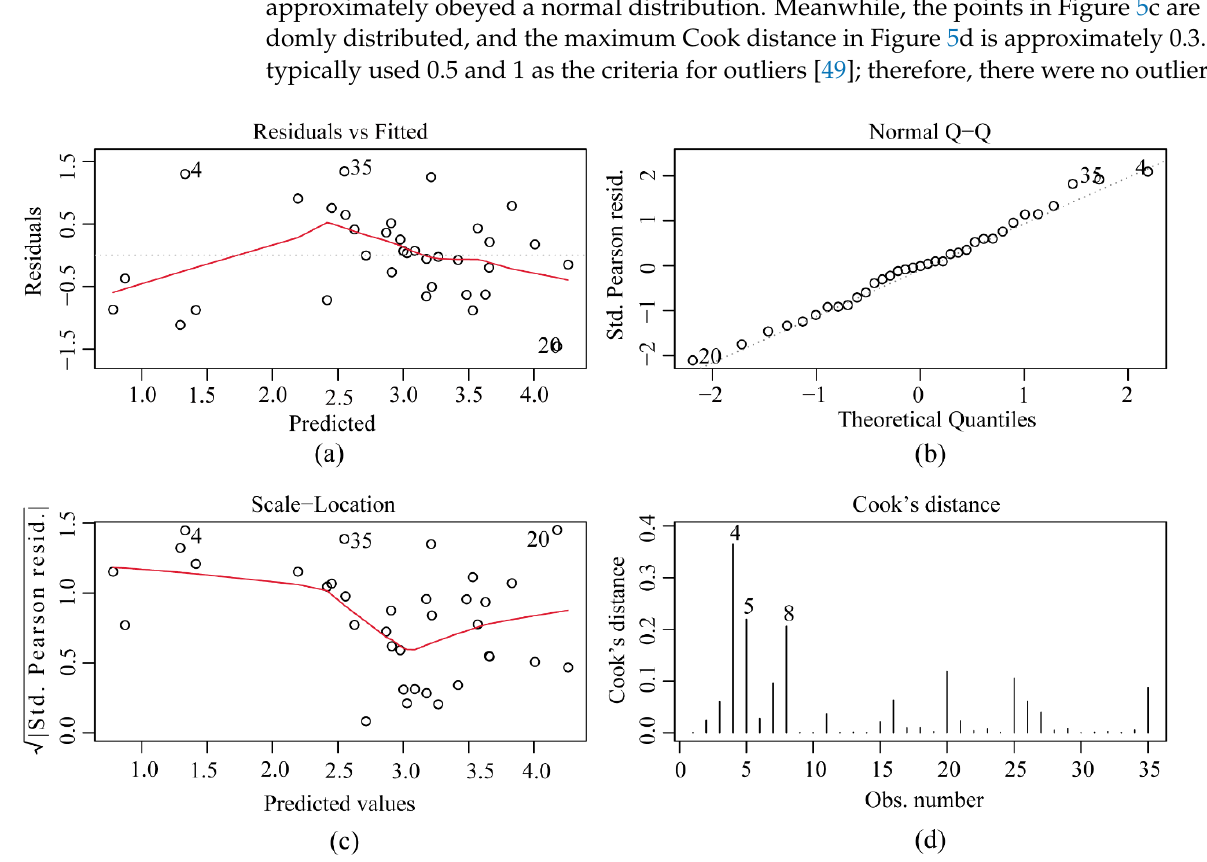
Figure 5. Ricker-E model validation and testing. ( a ) Residuals vs. Fitted; ( b ) Normal Q − Q; ( c ) Scale − location; ( d ) Cook’s distance.